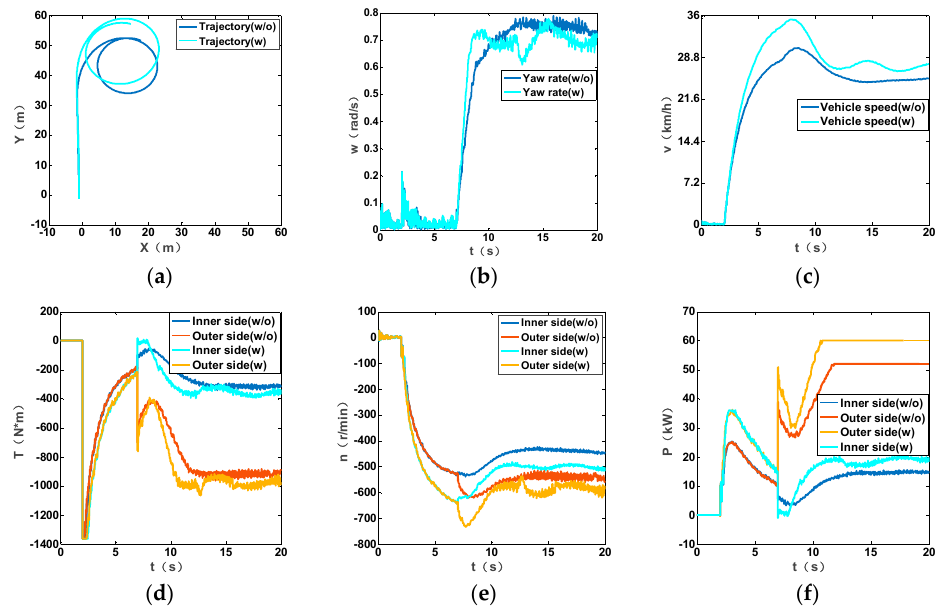
Figure 8. Simulation results of 5 B steering: ( a ) Trajectory; ( b ) Vehicle yaw rate; ( c ) Vehicle speed; ( d ) Sprocket torque; ( e ) Sprocket rotation speed; ( f ) Sprocket power.